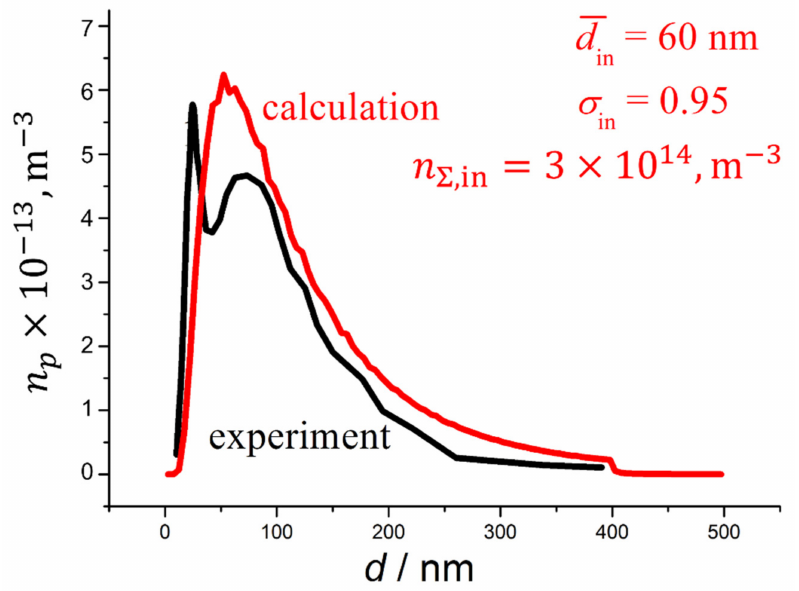
Figure 11. Comparison of measured [37] and simulated particle number concentrations at the outlet of the engine exhaust system. The values of d in , σ in , and n Σ ,in are obtained by solving the inverse